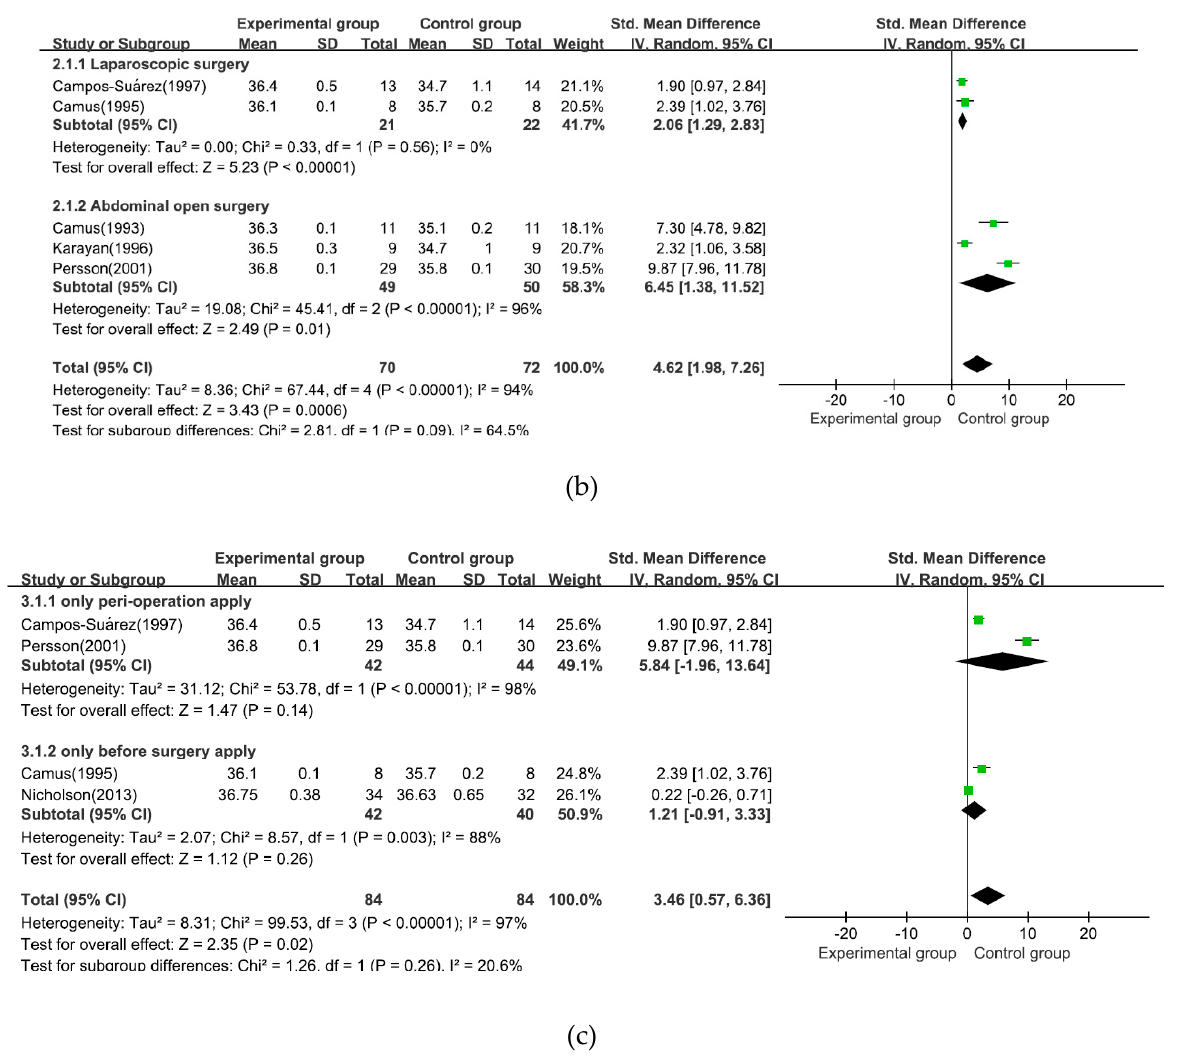
Figure 4. ( a ) Effect size of intervention; ( b ) subgroup analysis by surgery type; ( c ) application